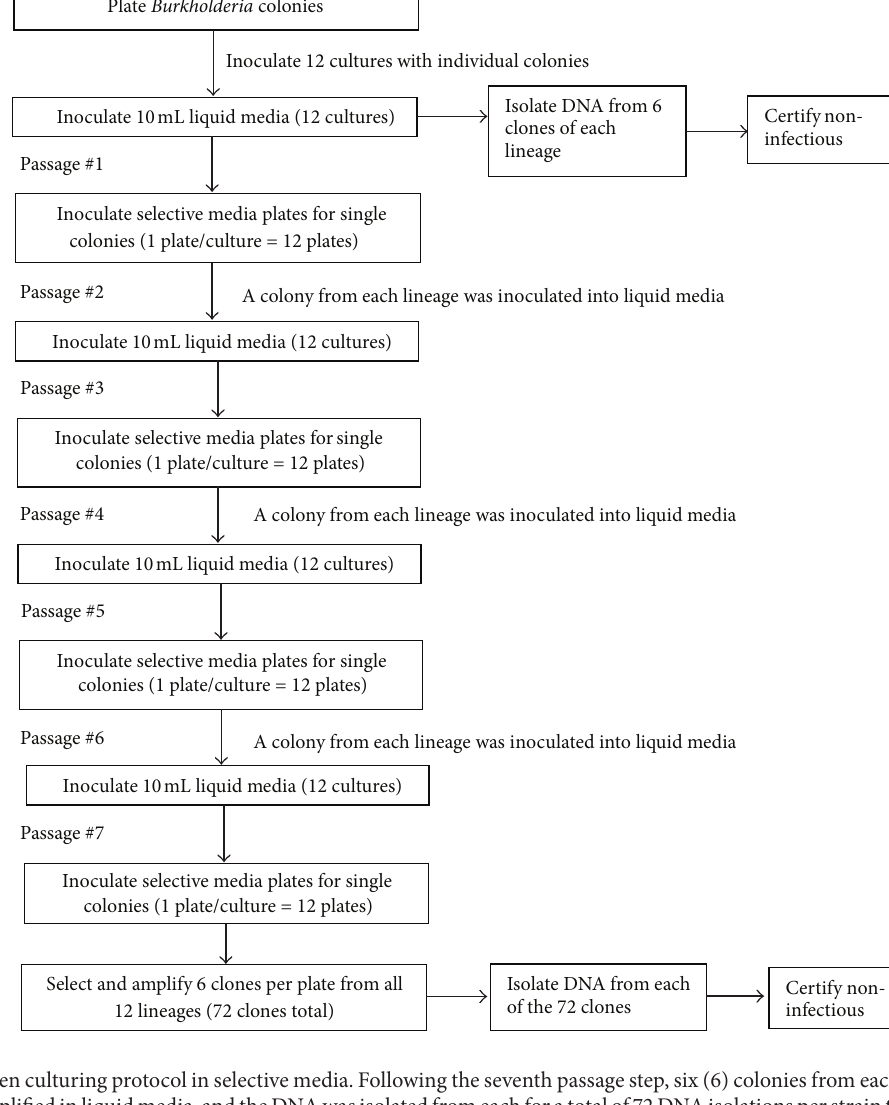
Figure 3: Pathogen culturing protocol in selective media. Following the seventh passage step, six (6) colonies from each of the twelve cultures wereselected,amplifiedinliquidmedia,andtheDNAwasisolatedfromeachforatotalof72DNAisolationsperstraintested.Afrozenarchive sample of each clone selected for DNA isolation will also be maintained for potential future